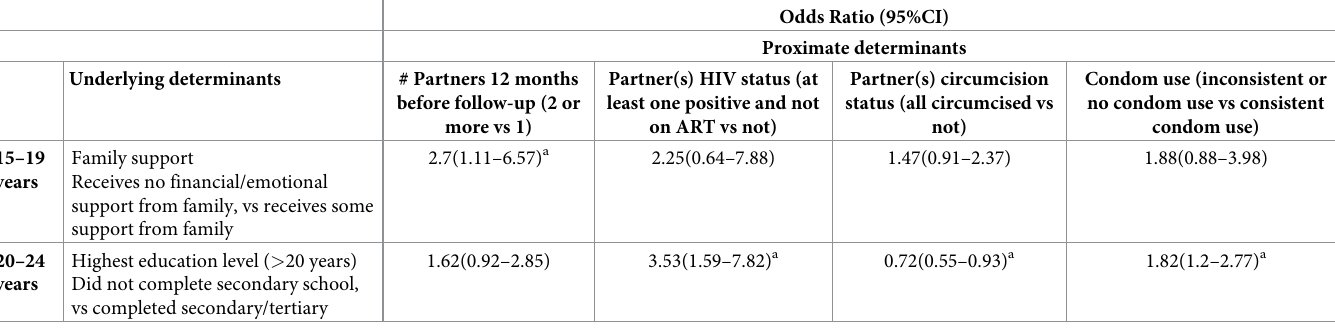
Table 4. Association between underlying and proximate determinants of HIV in adolescent girls and young women enrolled in the HIPSS